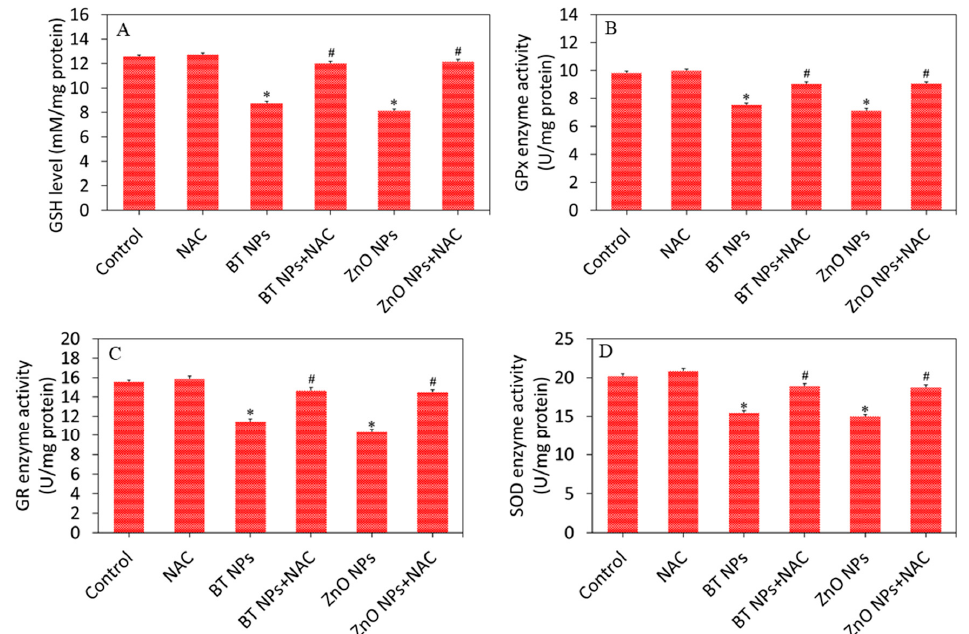
Figure 6. Antioxidant levels of A549 cells exposed for 24 h to 50 µ g / mL of BT NPs with or without NAC (2 mM). ZnO NPs (25 µ g / mL for 24 h) was used as a positive control. ( A ) GSH level. ( B ) GPx enzyme activity. ( C ) GR enzyme activity. ( D ) SOD enzyme activity. Data are provided as mean ± SD of three independent experiments ( n = 3). * Indicates statistically significant difference from the control group ( p < 0.05). # Indicates that NAC effectively abrogated the effect of BT NPs or ZnO NPs.